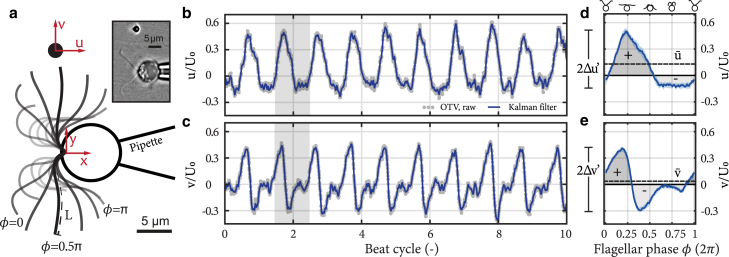
Optical tweezers-based velocimetry (OTV). (a) Schematic of the OTV measurements with an algal cell captured by a micropipette and optically trapped bead to measure flow velocities u and v. Inset shows a light microscope image from a typical experiment. Scale bars, 5 μm. (b and c) Periodic signals of (b) axial u and (c) lateral v flow velocities as a function of beat cycle. The gray points are raw OTV data, and the blue solid curve is data filtered with a Kalman filter. A typical beat cycle is shaded; it begins with the most forward-reaching flagellar shapes, defined as flagellar phase ϕ=0, shown in the inset of (a).The median cycle is constructed based on ∼50 cycles and shown in (d and e). (d and e) Flow velocities (d) u and (e) v over one average beat cycle. In (d), the dark gray “+” represents the power stroke, when propulsive flows are generated. The light gray “−” represents the recovery stroke when the flagella move opposite to the swimming direction. In (e), the + and −, together with their shadings, mark, respectively, the propulsion outwards and inwards in the cell’s lateral direction. The flow amplitudes Δu′ and Δv′ are depicted on the left. The dashed lines represent the average velocities u¯ and v¯. The data shown in (b)–(e) are from a cc125 cell. To see this figure in color, go online.